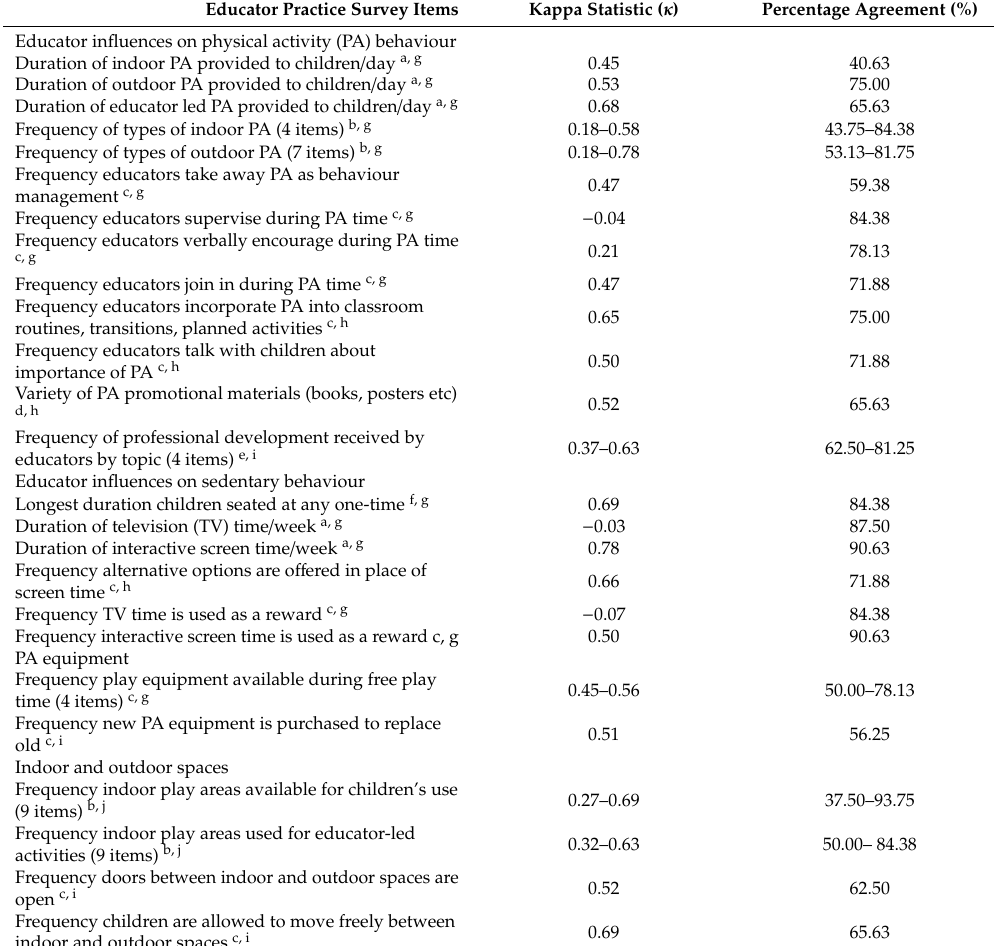
Table 2. Test-retest reliability results for the ECEC educator practice